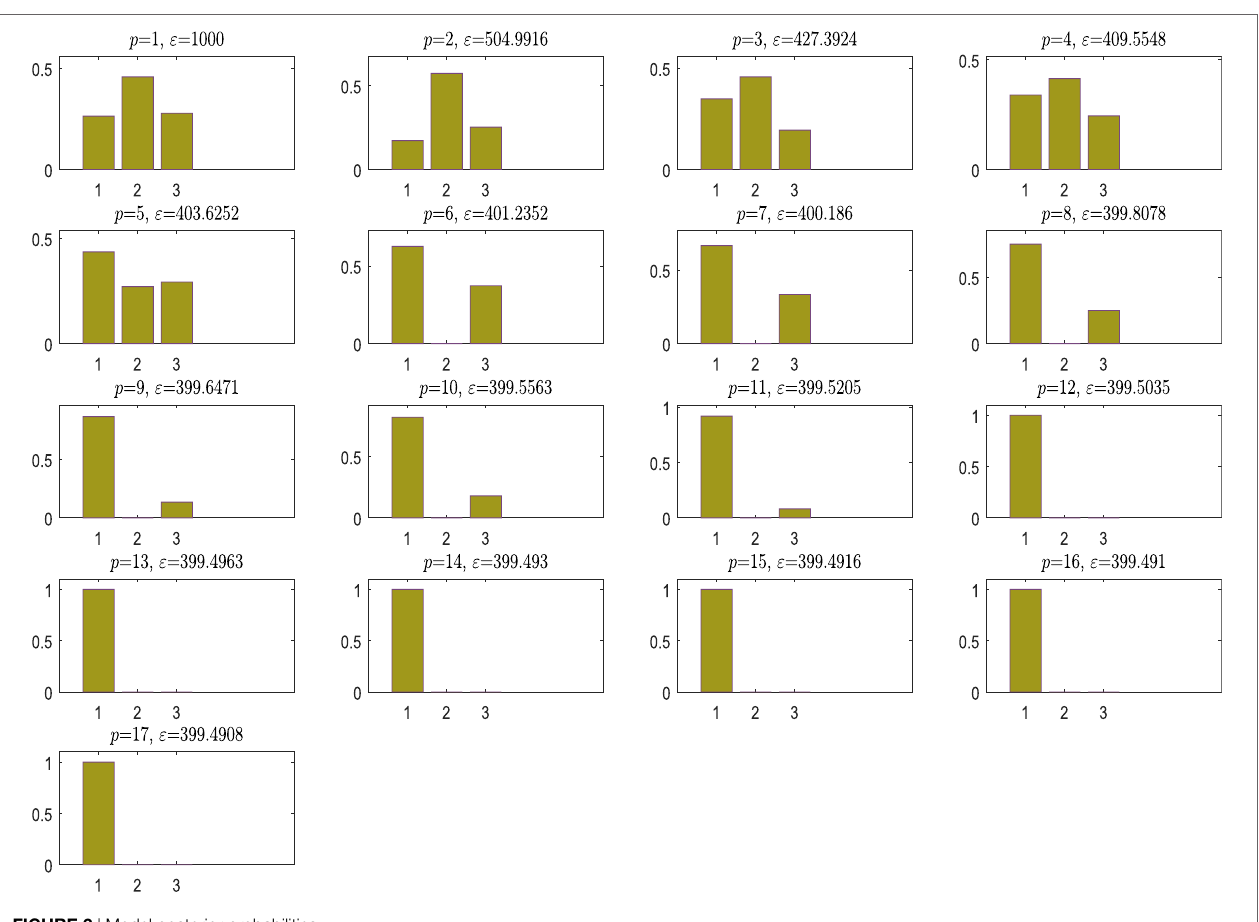
FIGURE 2 | Model posterior